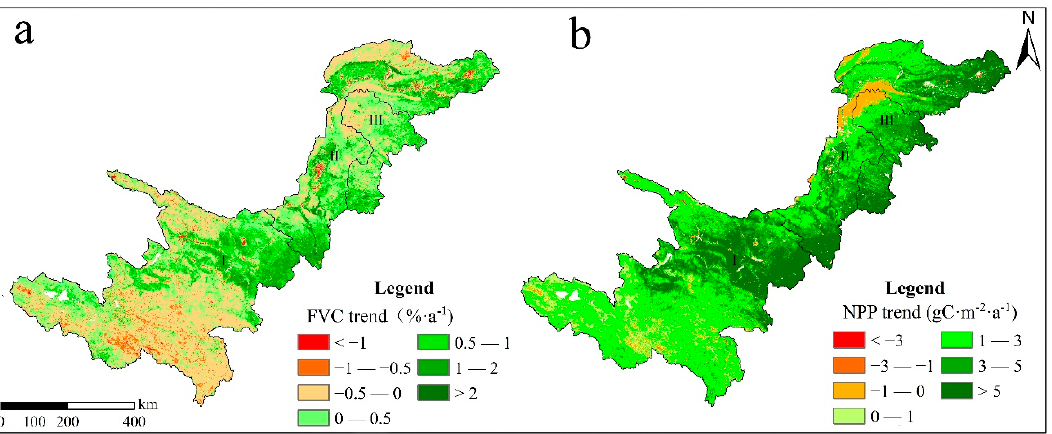
Figure 3. Spatial distributions of the FVC ( a ) and NPP ( b ) change rates in the Upper Yellow River region from 2000 to 2019.